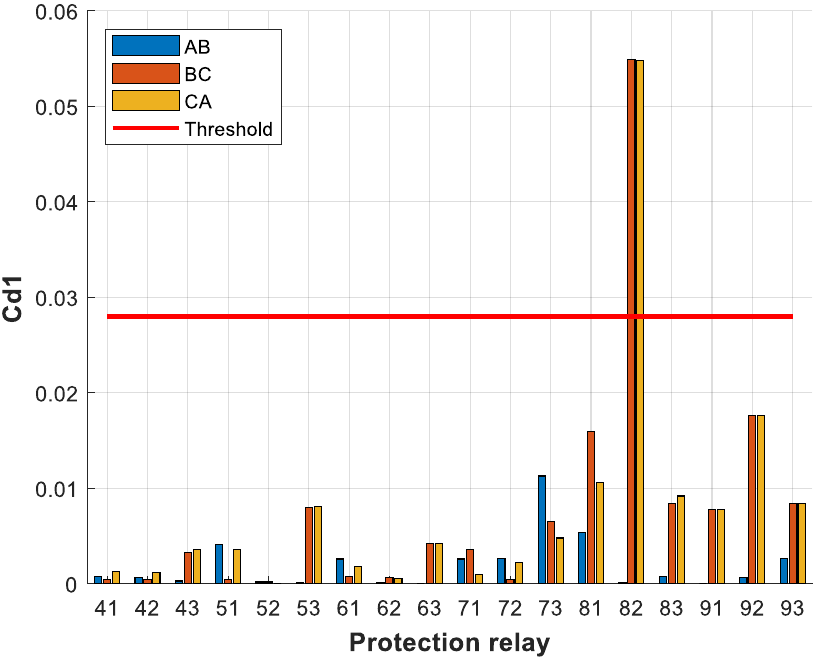
Figure 12. Differences in the current Cd1-dB2 on the transmission line from bus 8 to bus 9.